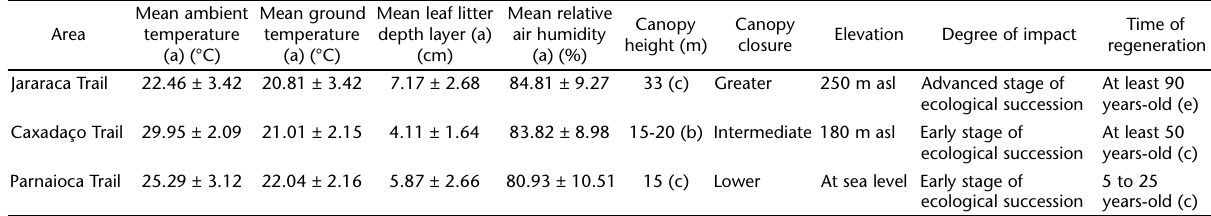
Table I. Summary of local environmental parameters from three areas (Jararaca, Caxadaço and Parnaioca trails) at Ilha Grande. Area